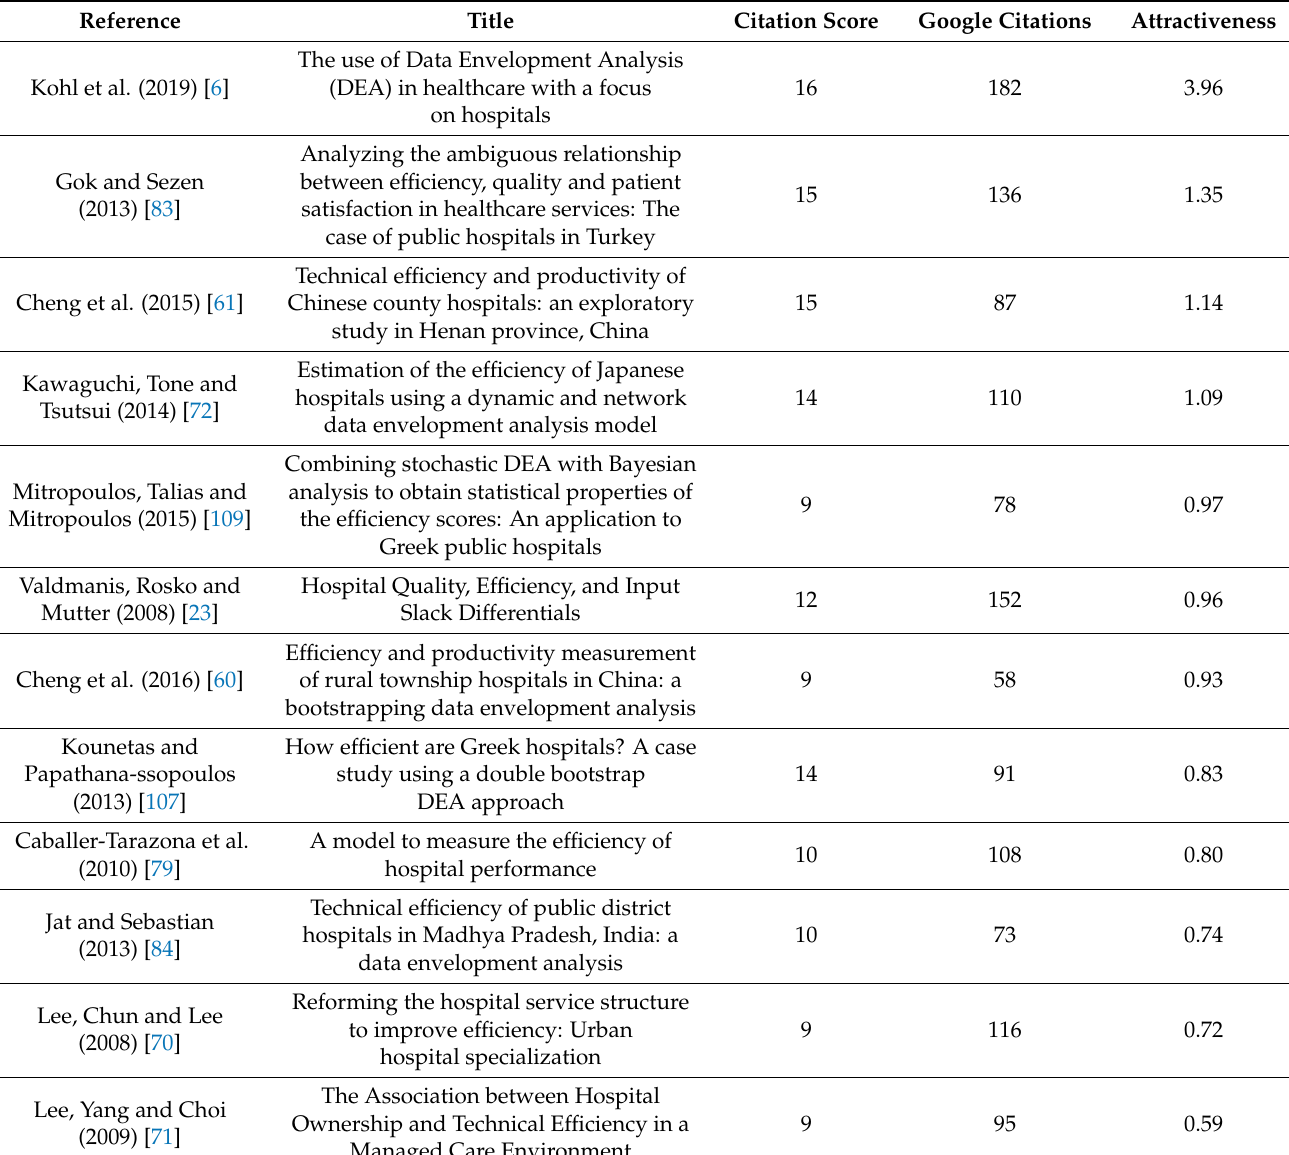
Table 3. Most relevant